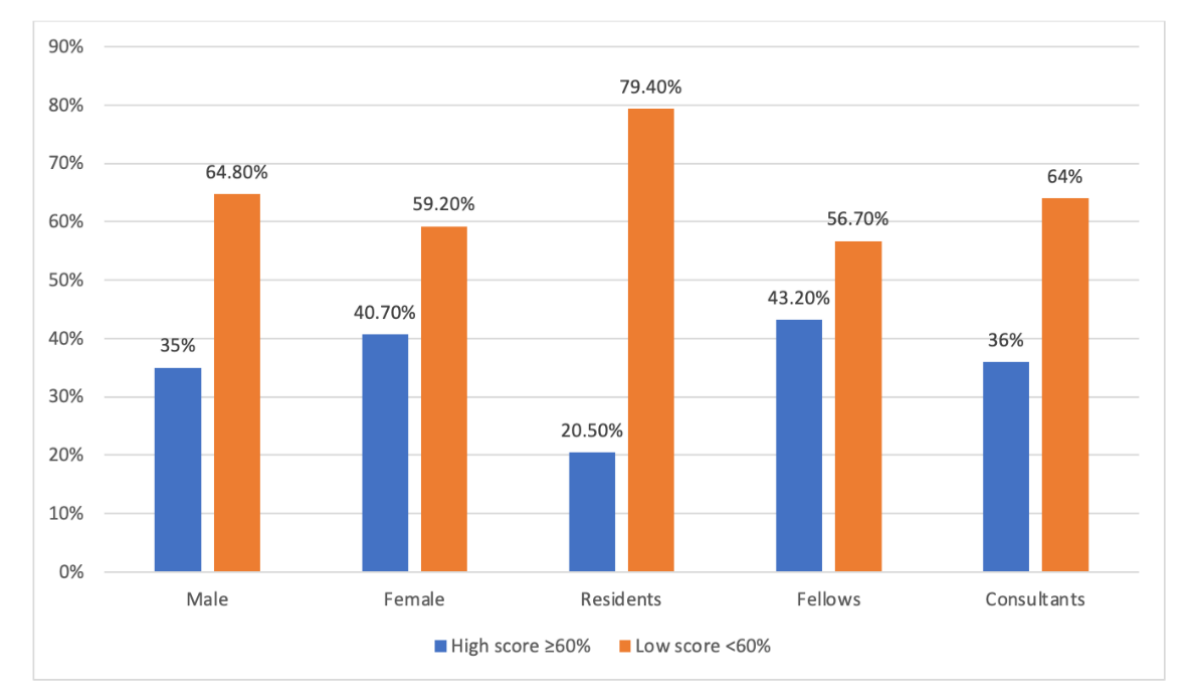
Figure 1. Percentages of high and low scores across gender and different groups of